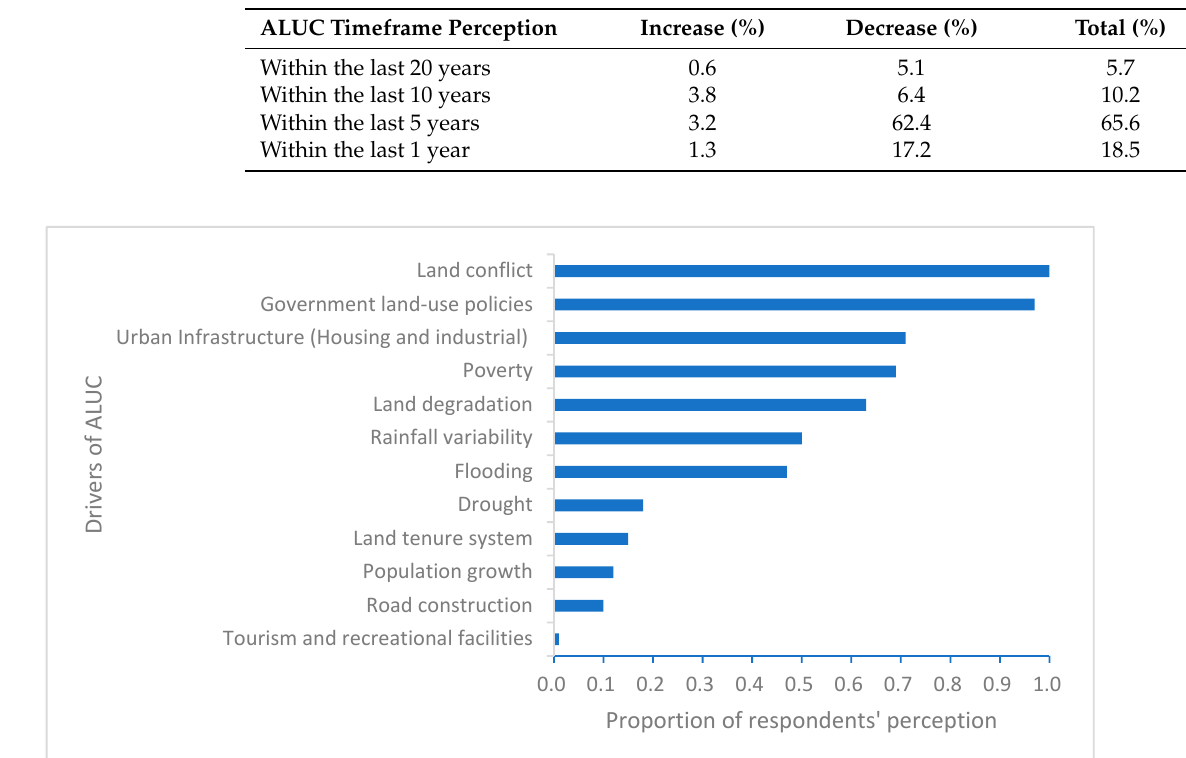
Figure 2. Factors driving agricultural land-use change perceived by farmers in Benue State, Nigeria.